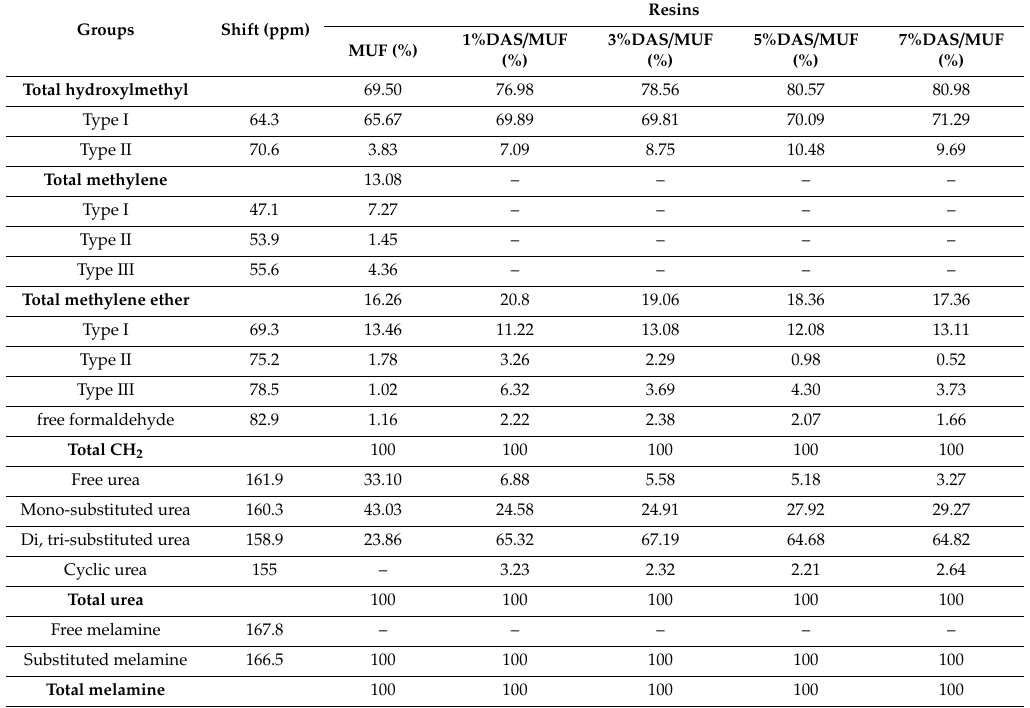
Table 2. Percentage integration values for various methylene and carbonyl carbons of neat MUF and DAS-modified MUF resins determined from 13 C Nuclear Magnetic Resonance ( 13 C NMR)